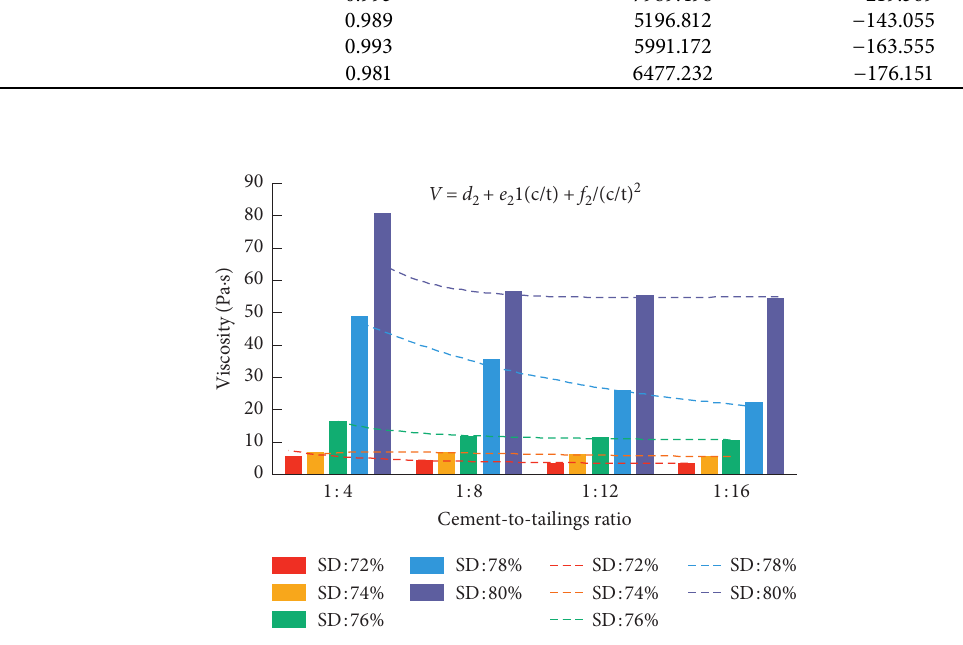
Figure 6: Histogram between c/t and viscosity of CUTB samples.